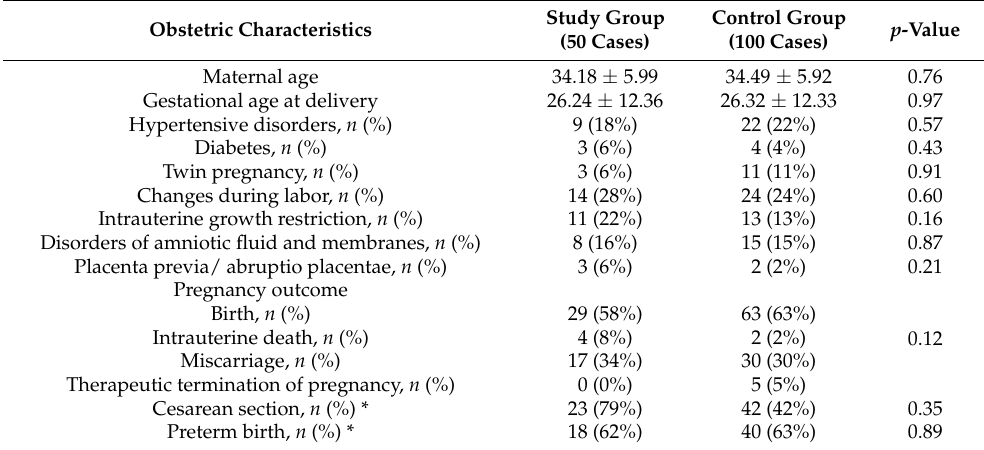
Table 1. Obstetric characteristics in study and control group.